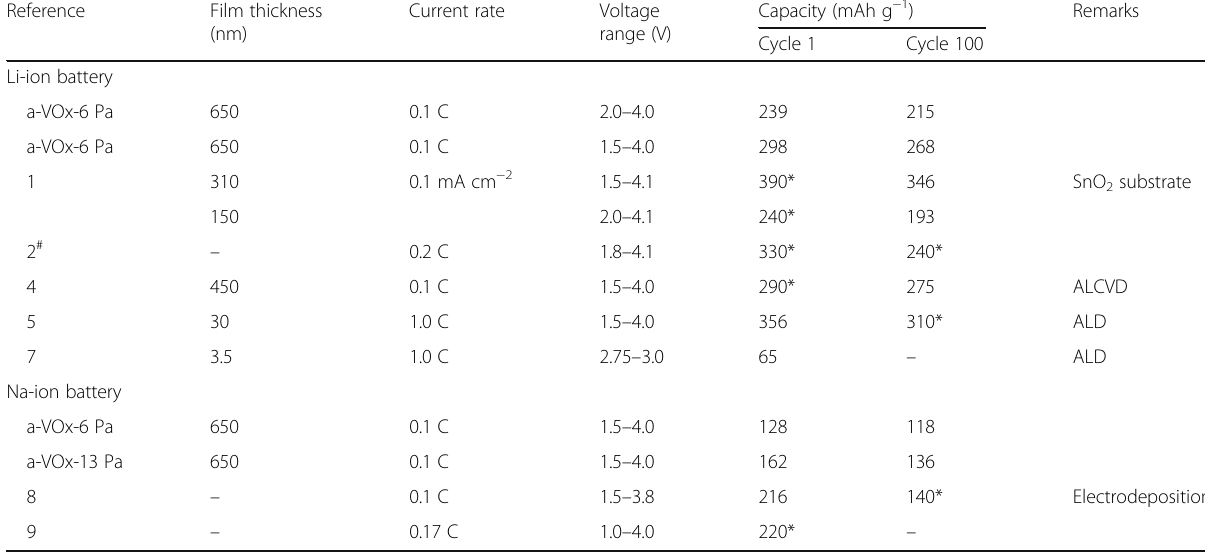
Table 4 Li-ion battery performance comparison of a-VOx-6 Pa films with other its class of materials